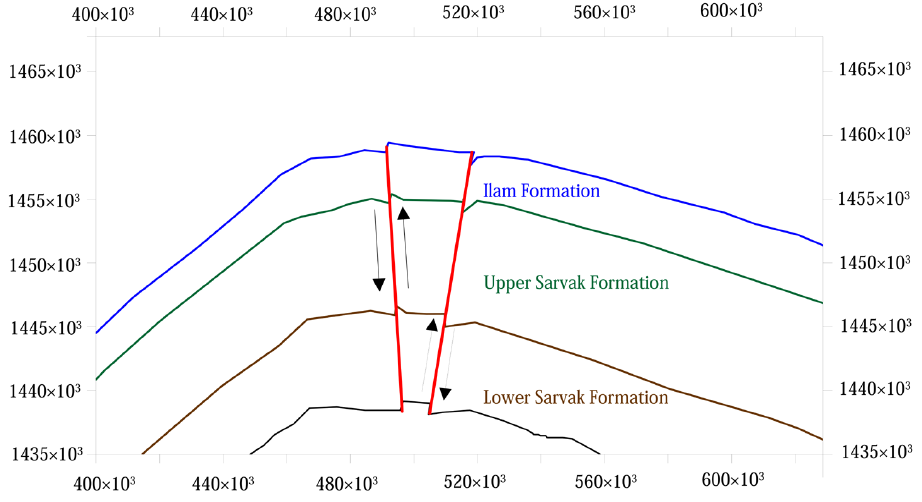
Figure 9. The tectonic structure resulted from reverse faults performance in the Azar oilfield.